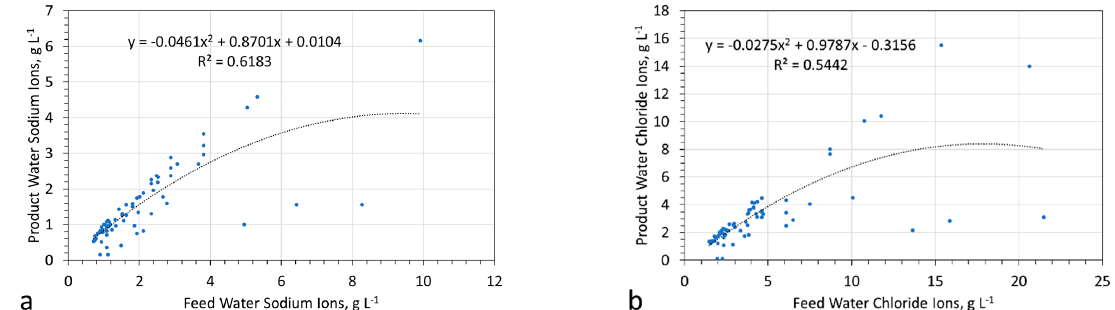
Figure 7. Redox parameters. ( a ) pH; ( b ) Eh.